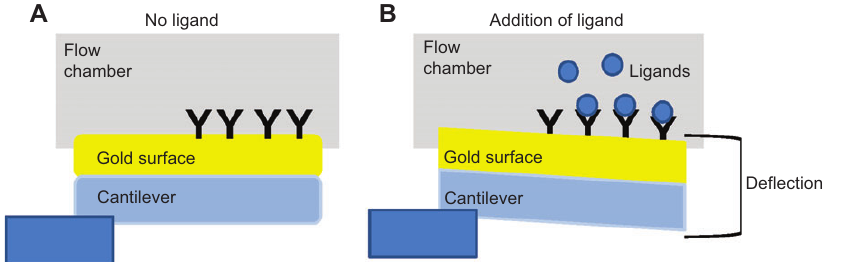
Figure 7 Diagram of a mechanical cantilever. (A) Protein is immobilized onto a gold surface. When no ligand is present, bending does not occur. (B) Once ligand is added, it binds to the immobilized protein, which causes bending defined as deflection ( σ